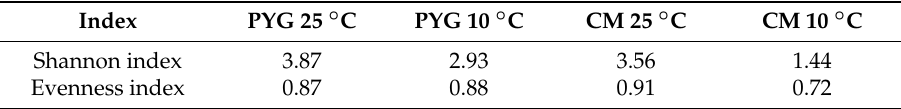
Table 1. Ecological indices characterised of cultured communities.